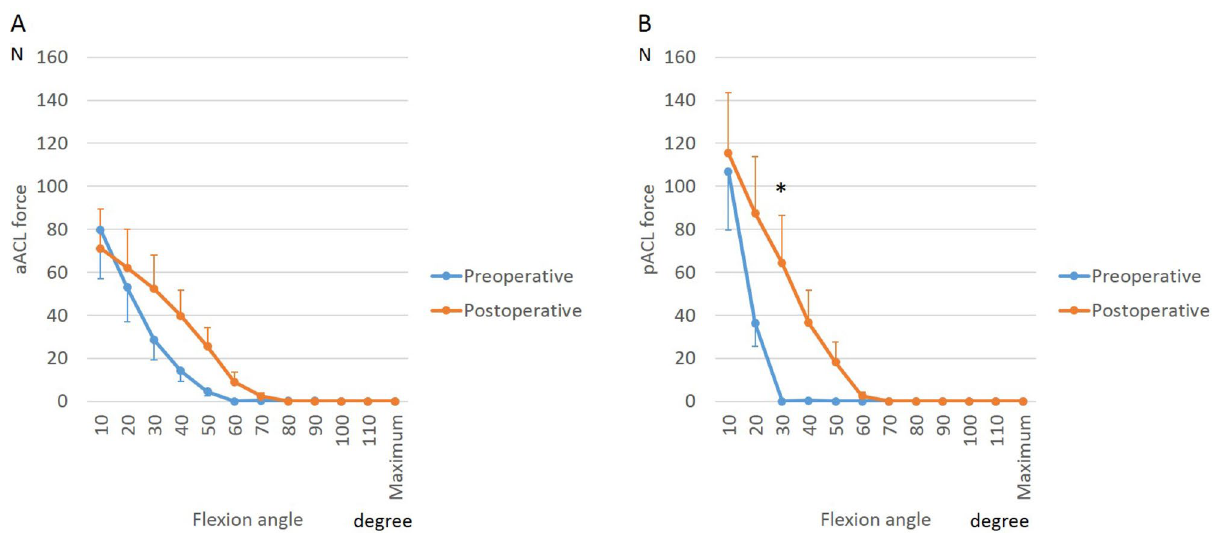
Figure 5. Anterior cruciate ligament (ACL) force during squatting before and after bicruciate-retaining total knee arthroplasty: ( A ) Anteromedial bundle of the ACL (aACL); ( B ) Posterolateral bundle of the ACL (pACL). *A significant difference between preoperative knees and postoperative knees ( p ≤